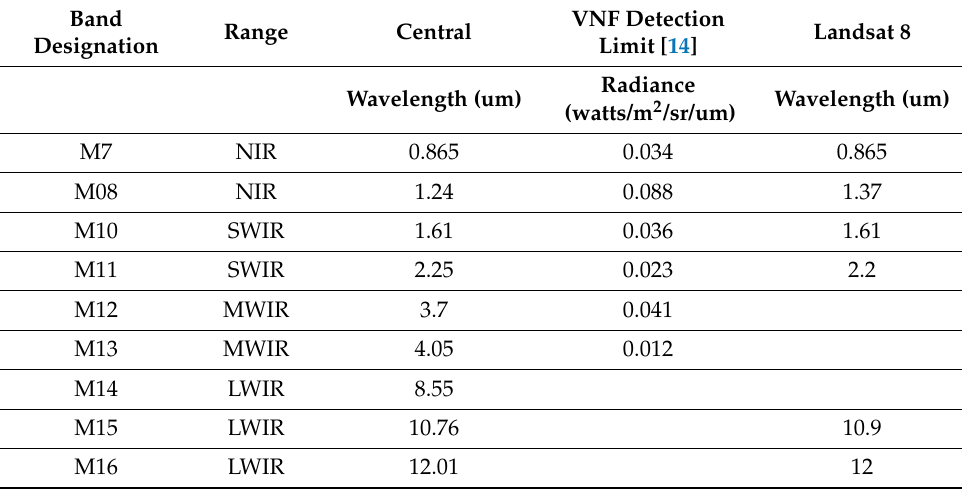
Table 1. The VIIRS Nightfire Spectral Bands and Landsat